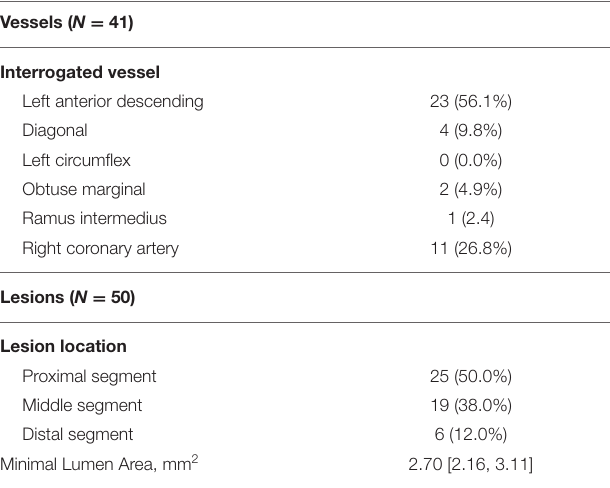
TABLE 2 | Baseline lesion characteristics.